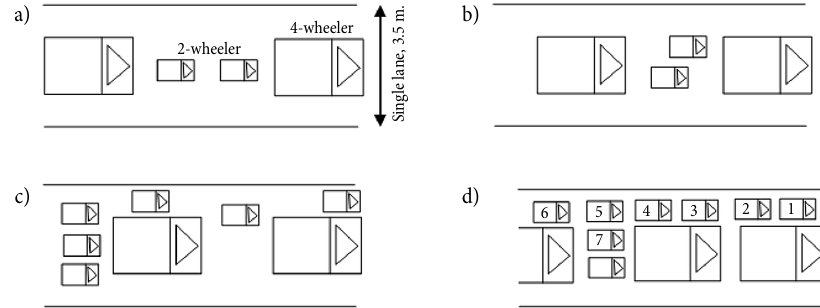
Fig. 1. MTW and four-wheeler interaction assumed in the conventional models, equivalent to the heterogeneous free flow traffic (a); MTWs with the side-by-side movement at higher densities (b); MTWs occupying the sides of four-wheelers at even higher densities (c); peak-hour conditions or jam conditions (d)